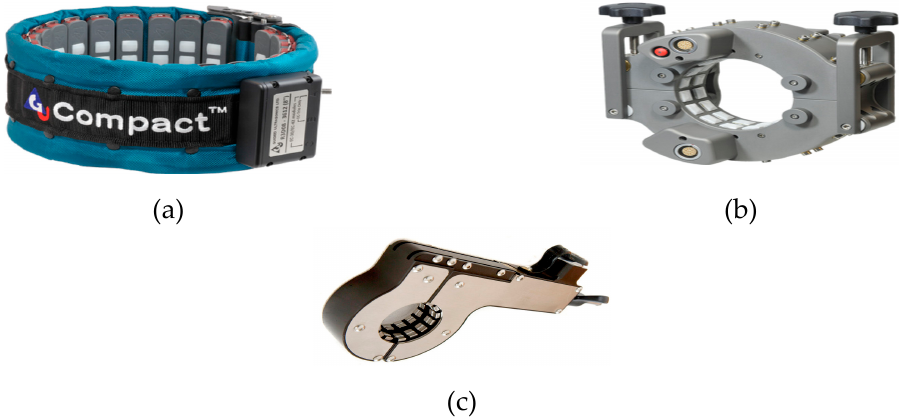
Figure 5. ( a ) Compact ring transducer; ( b ) Solid ring transducer; ( c ) Claw transducer [87].